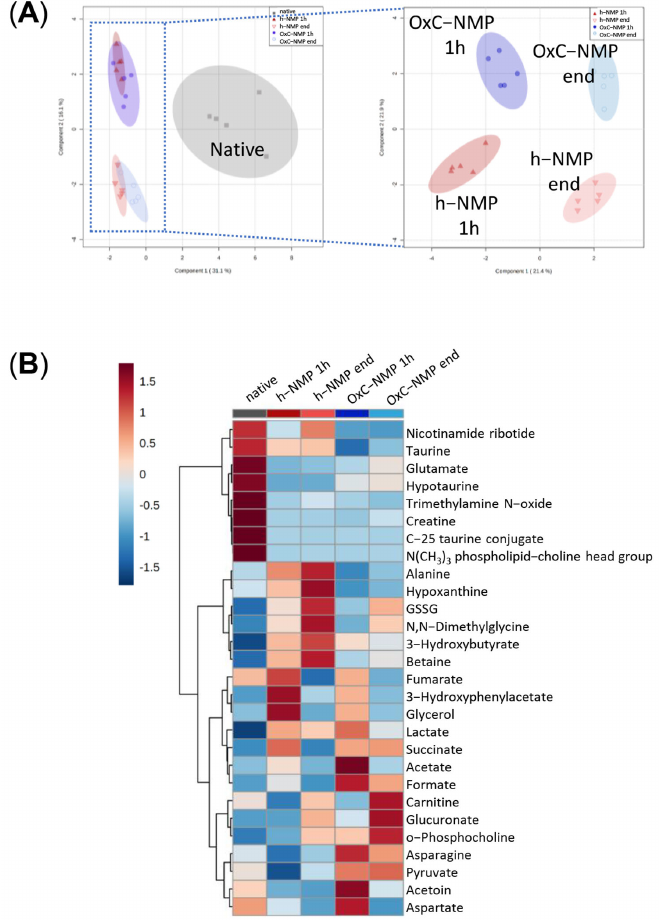
Figure 4. Metabolite concentration changes in bile samples. ( A ) sPLS-DA scores plots illustrating group separation based on sparse partial least-squares discriminant analysis. When excluding the Native group (dark grey squares), further separation of groups is achieved due to changes in metabolite concentrations in time; h − NMP 1h—dark red triangles, h − NMP end—light red downwards triangles, OxC − NMP 1h—dark blue full dots, OxC − NMP end—light blue empty dots. ( B ) Averaged heat map illustrating all the group metabolite changes—overview average for each group. Red—relatively increased concentration, blue—relatively reduced concentration. Abbreviation: GSSG, glutathione disulfide (oxidized